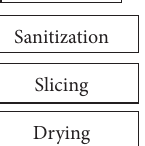
better absorbed by the body when the tomato is cooked, thus, ideal for the consumption of tomato sauces and soups.